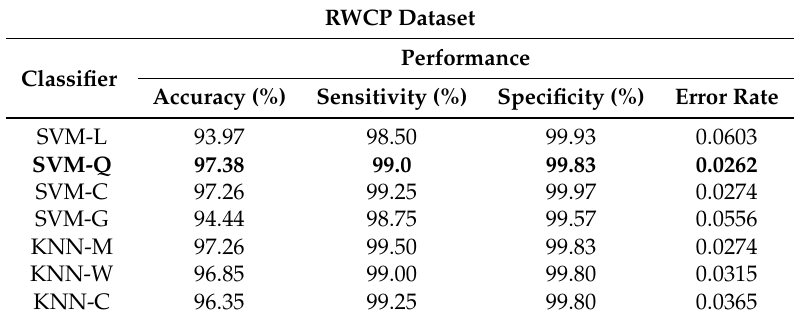
Table 5. Performance of various classifiers for proposed feature extraction approach for RWCP